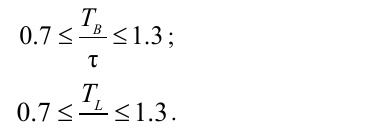
Fig. 1. Block diagram of the vessel automatic storm